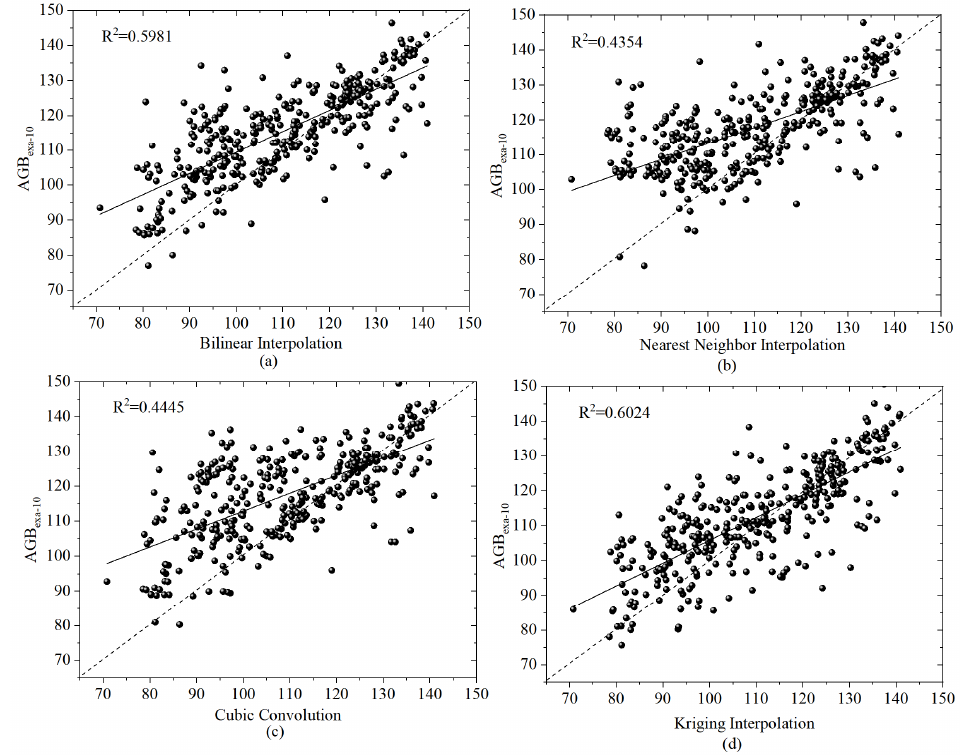
Figure 10. Scatter plot between measured and geostatistical scale-corrected AGB at 10 m resolution. In the same way, the corrected AGB values using bilinear interpolation, the nearest neighbor method, cubic convolution and the Kriging interpolation method were also calculated and the accuracy was compared with Landsat-8 AGB estimation. The R 2 values of the four method were 0.5369, 0.4916, 0.5476 and 0.5747, respectively. Among these results, the Kriging interpolation method showed a good capacity for upscaling, with higher accuracy (Figure 11). However, the results corrected by the Kriging interpolation method still showed lower accuracy compared with the method of this study, with R 2 of 0.6704. The main reason was that a constant AGB value at different scales was selected, and it could be considered as a ruler, which was used to measure the scale error. After this, the scale conversion method with the entropy-weighted index was used to correct the scale error of the coarse-resolution image. Since the information entropy weight index considered the information entropy of the land use type, the heterogeneity of the surface feature could be fully considered. At the same time, this entropy weight index varied pixel by pixel and thus the correction index of the scale error for each pixel could be calculated, realizing the AGB scale error correction with various spatial